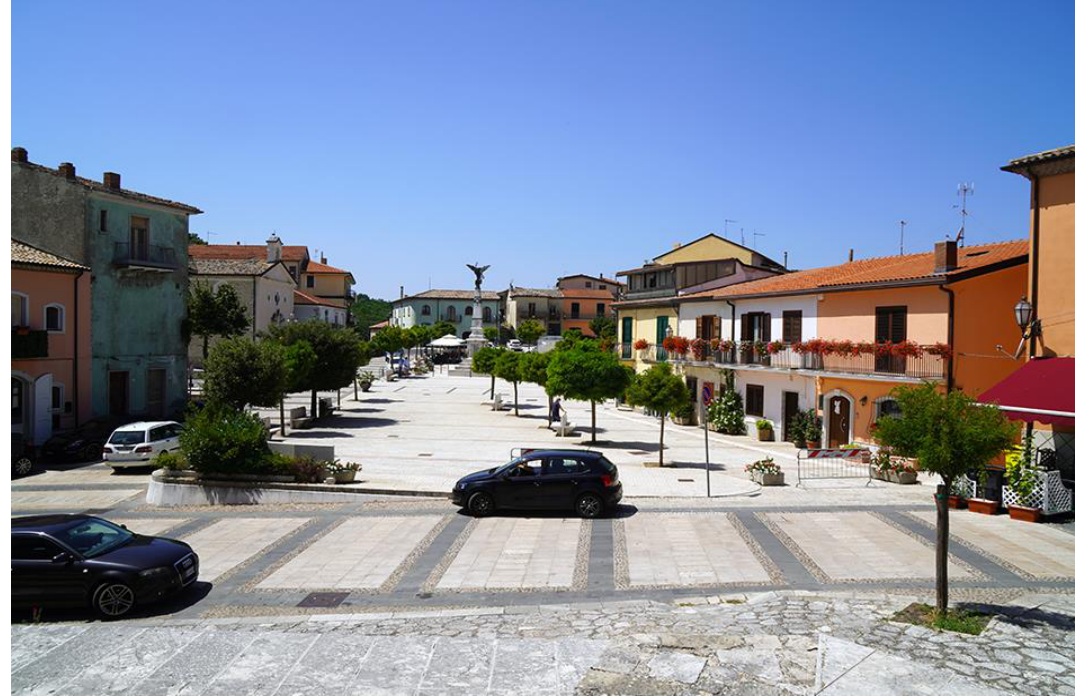
Figure 71. Guardia dei Lombardi: panoramic view of the new village (photos by [35,36]).